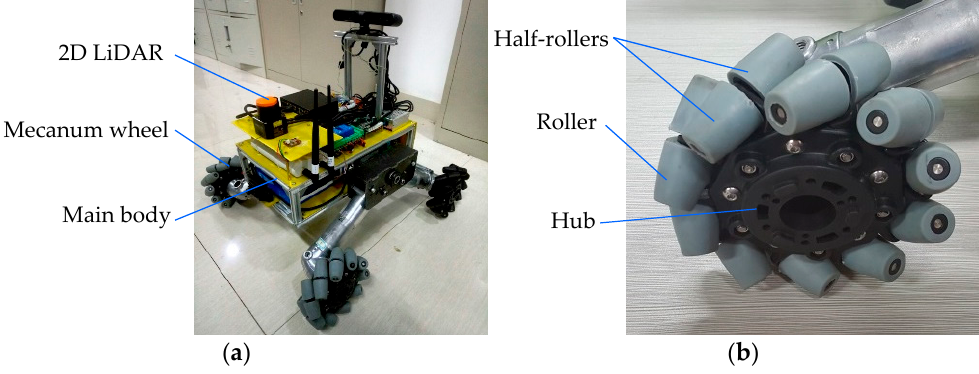
Figure 23. Pictures of the Mecanum wheel mobile robot used in this paper: ( a ) Mecanum wheel mobile robot; ( b ) Mecanum wheel of the robot.